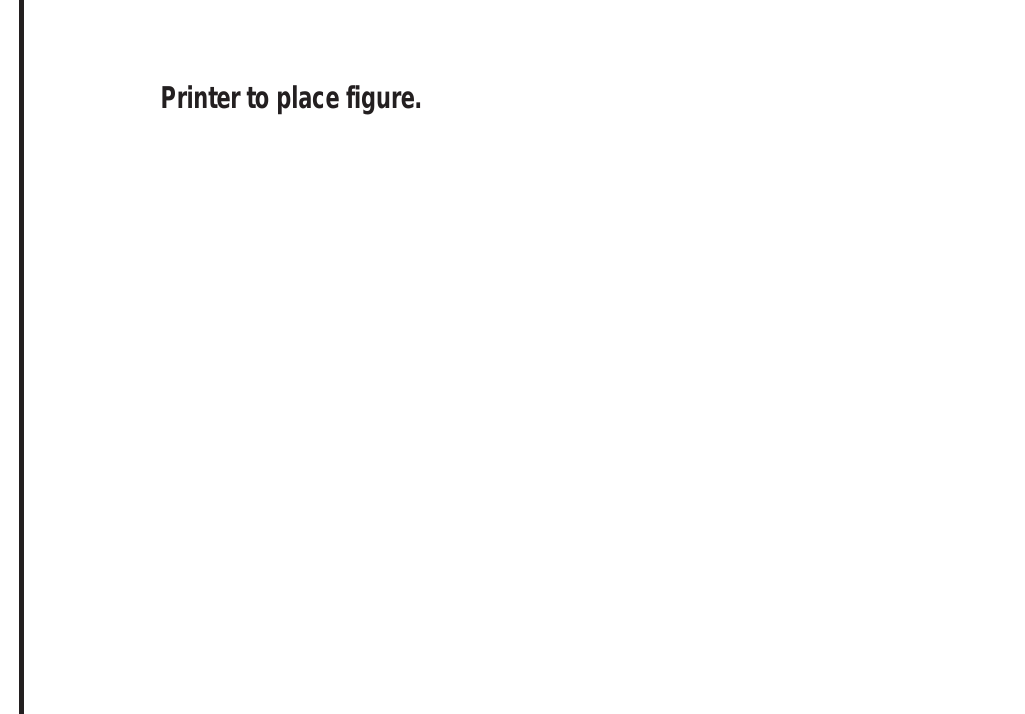
Printer to place